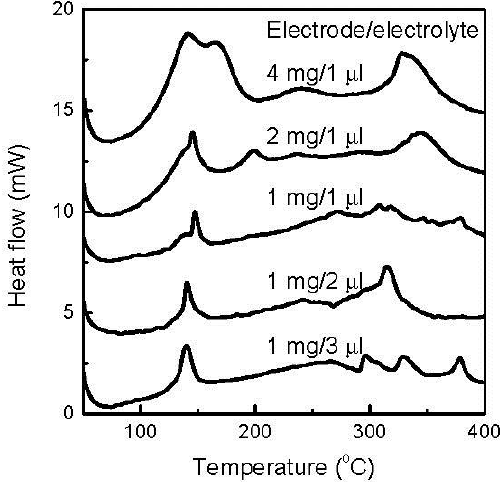
Figure 6. DSC curves of discharged FeOF cathodes down to 0.7 V with associated electrolytes in various cathode/electrolyte ratios.